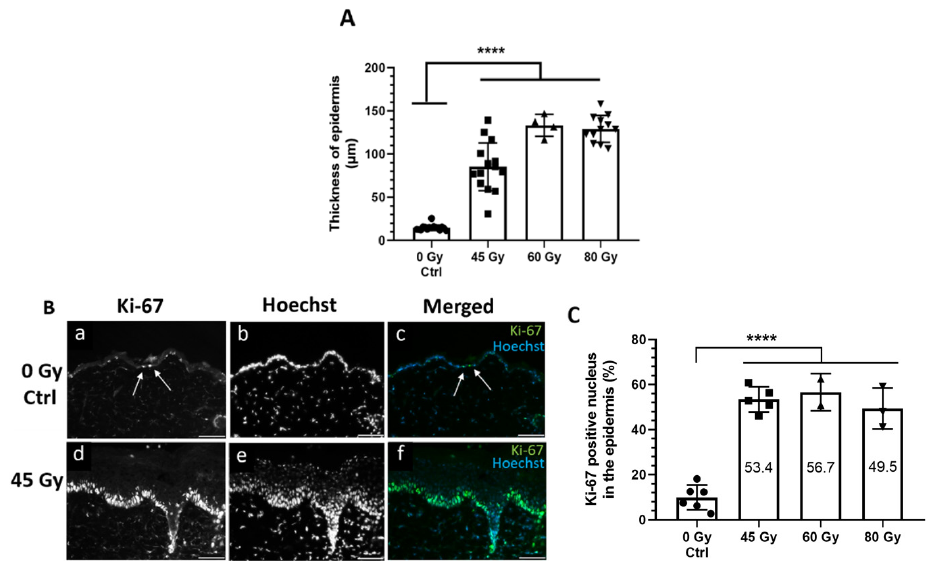
Figure 4. Epidermal thickness and Ki-67 expression are increased in murine irradiated epidermis 28 days after irradiation. ( A ) Mean thickness of the epidermal compartment. Statistics: mean ± SD. n = 4–16 mice/group. ( B ) Immunolabeling for Ki-67 on a representative skin biopsy 28 days after irradiation with a 45 Gy dose in comparison to normal skin. Nuclei are stained with Hoechst. Bars = 100 µm. ( C ) Quantification reveals a significant increase of Ki-67 positive nuclei in the epidermis of irradiated compared to non-irradiated skin. Statistics: mean ± SD. n = 2–6 mice/group, One-way ANOVA with Dunnett’s multiple comparisons test **** p < 0.0001.